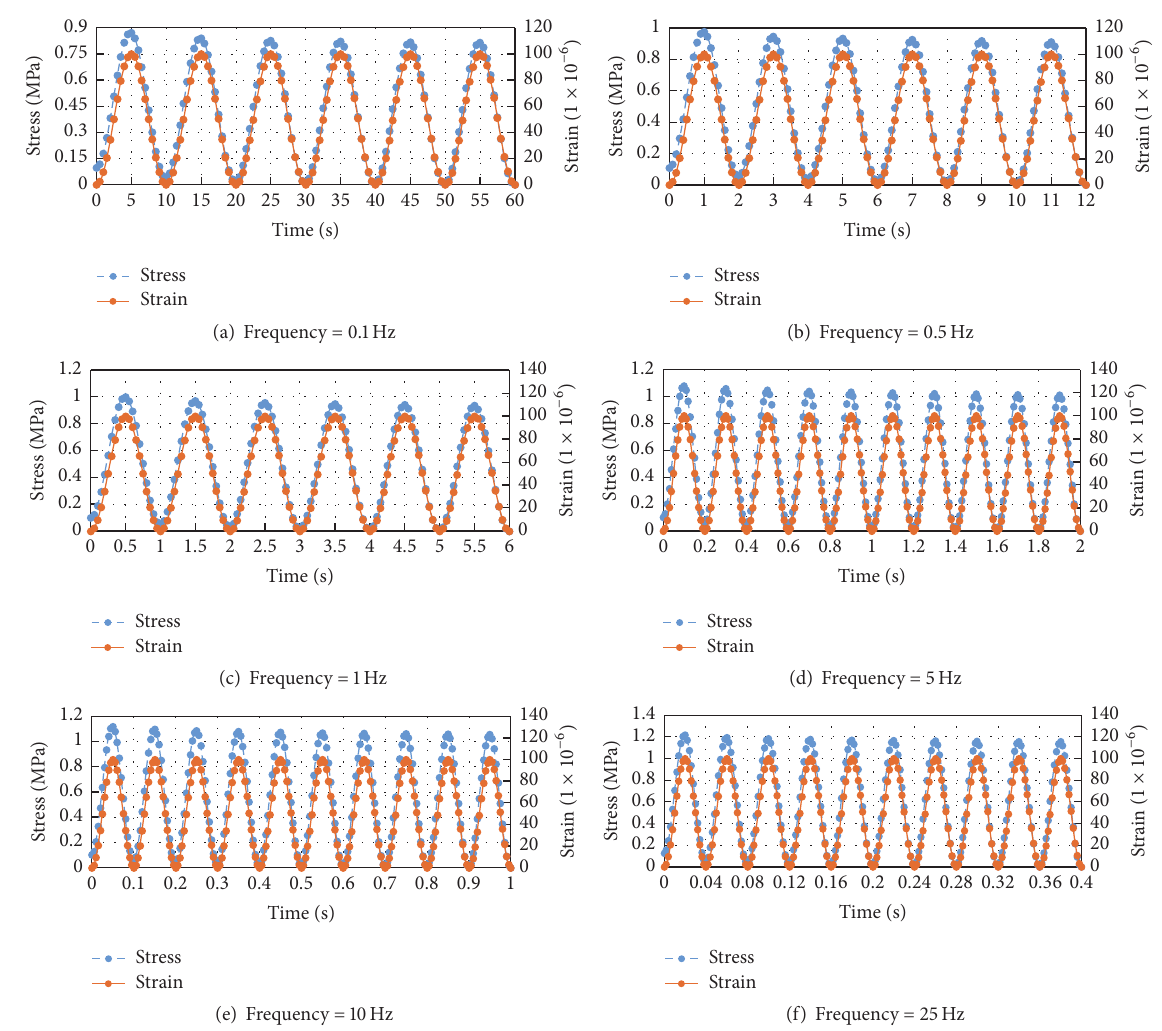
Figure 6: The stress/strain-time responds of the dynamic simulation under different frequencies.